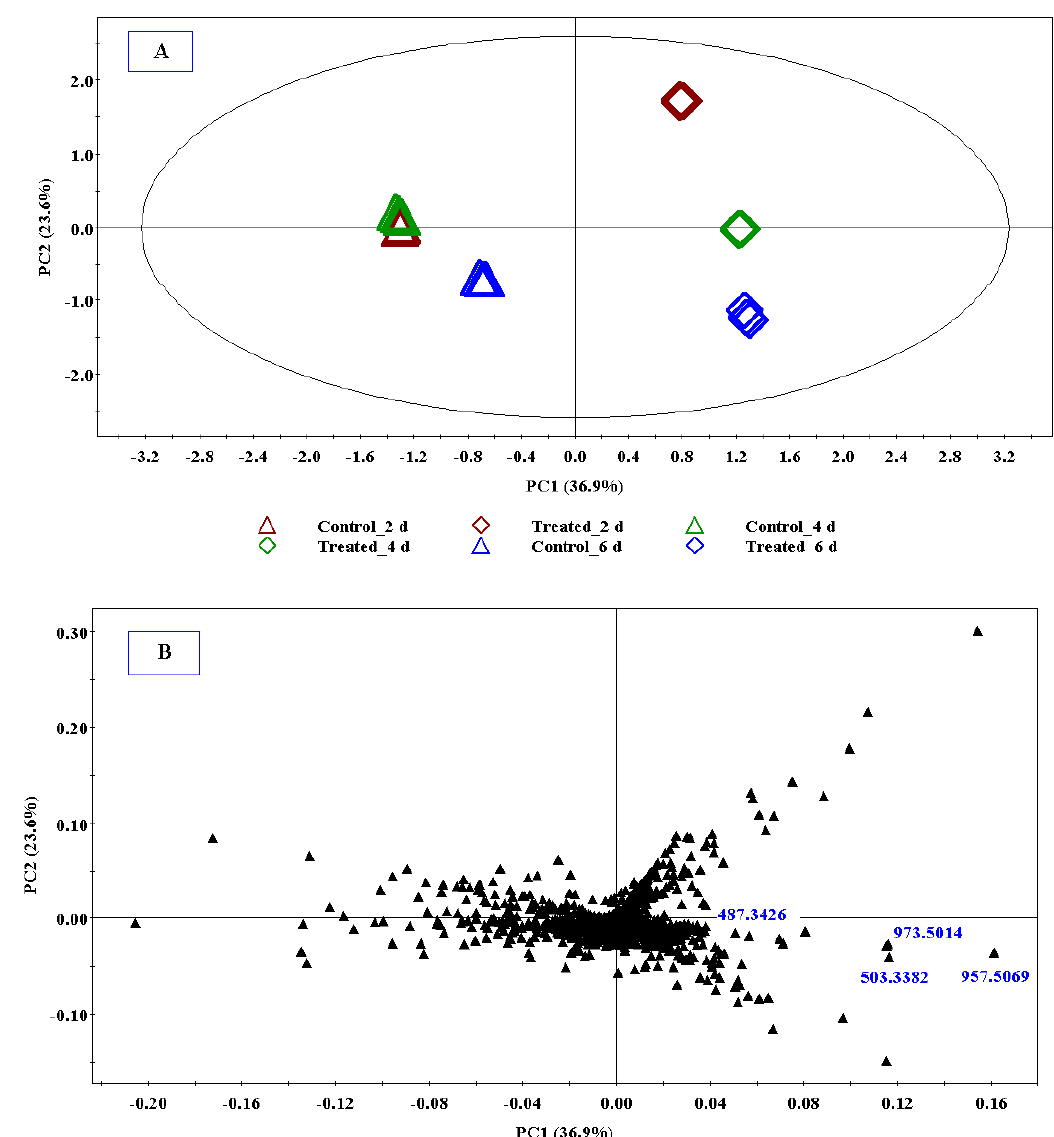
Figure 2. ( A ) PCA scores plot of a representative experiment. A 4-component model explains 87.2% variation. The plot was computed using the first two components (PC1 and PC2) which explain 60.5% of the variation ( B ) PCA loading plot for all time points (2, 4 and 6 days). The mass ions m/z = 487.3426, 957.5069, 503.3382 and 973.5014, identified as asiatic acid, asiaticoside, madecassic acid and madecassoside respectively, contribute to the clustering of the